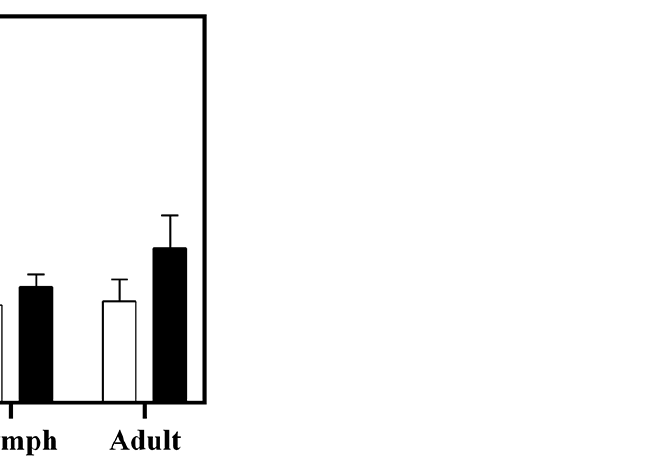
Figure 1. RT-qPCR expression analysis of ACCase gene expression in different life stages between the LS and DL-SC strains. Error bars represent the standard deviation of the calculated mean based on three biological replicates. In each panel, means without asterisks indicate not significantly different (t-test, p > 0.05).